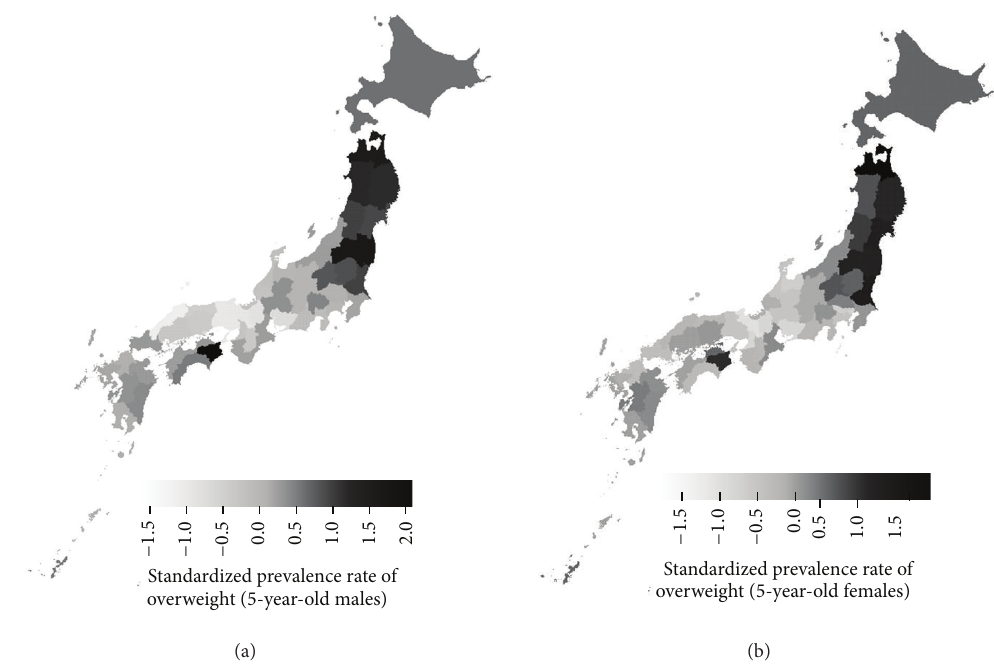
Figure 2: Distribution map of the standardized prevalence rate of overweight in Japanese children. Distribution map of 8-year (2006–2013) averagesofthestandardizedprevalencerateofoverweightin(a)5-year-oldmalesand(b)5-year-oldfemalesineachprefecture.Theprevalence rate of overweight in Japanese children tends to be greater in the northern areas and in Tokushima and Okinawa prefectures for both